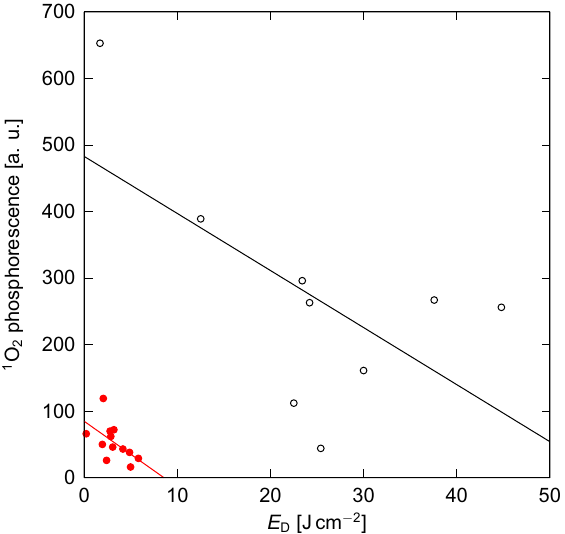
Fig. 9. The correlation between the total intensity of 1 O 2 lu- minescence at the initial exposition with exposition when the photoproduct °uorescence band becomes dominant ( E D ) at individual spots in lesion (open circles) and normal skin (full circles) of MAL-treated animals accompanied by linear approximations of the dependencies.